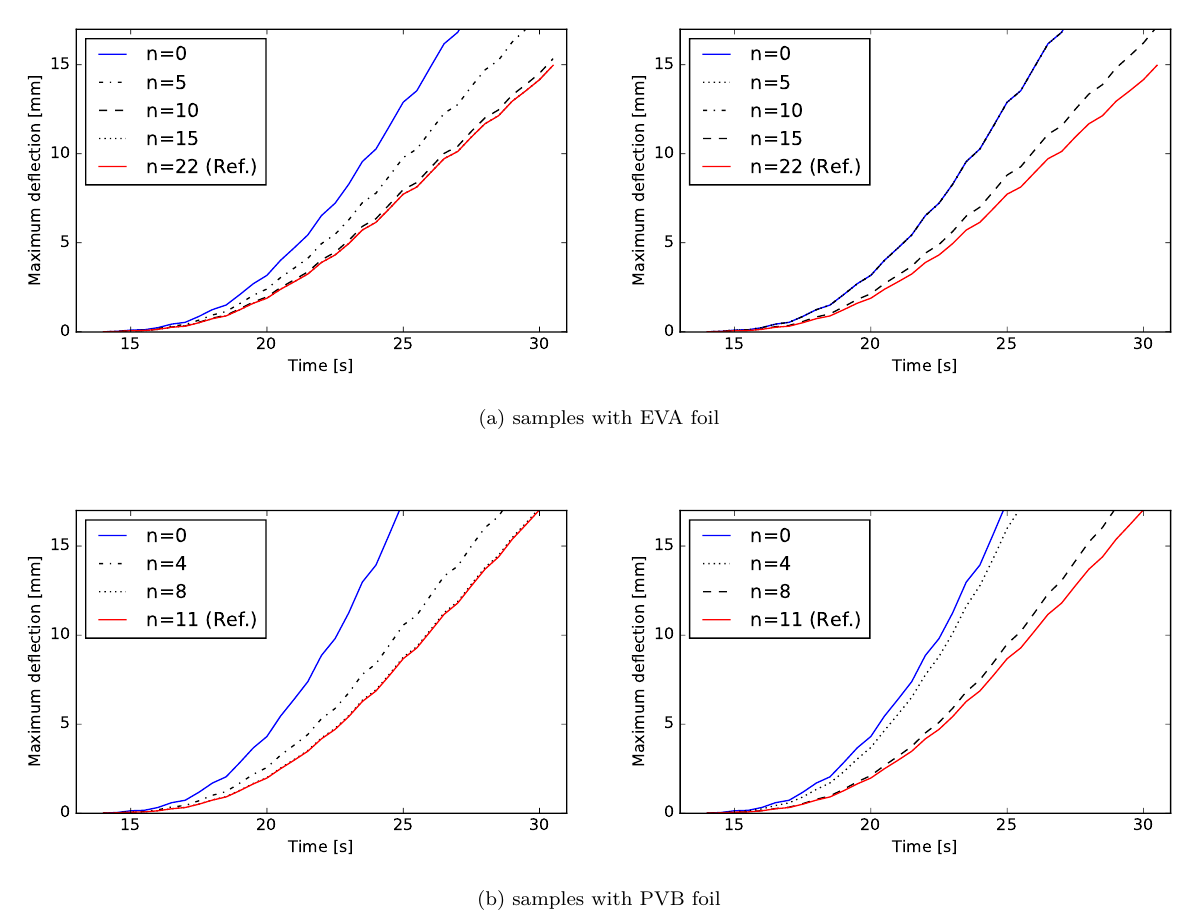
Figure 9. Time evolution of deflections predicted by the backward Euler method with time step ∆ t = 0 . 5 s: Reference – numerical simulation with all Maxwell (spring-dashpot) cells or Reduced – with n Maxwell cells if the cells with the smallest relaxation times (left) or the largest relaxation times (right) are